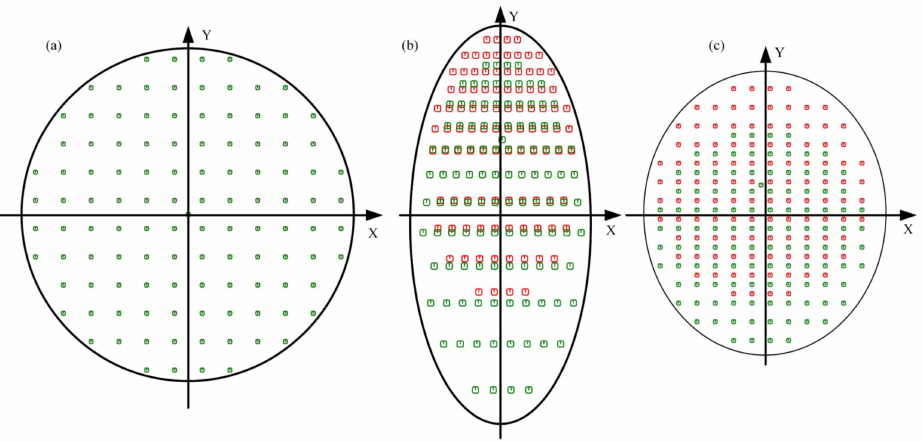
Figure 3. The red marks and the green marks, respectively, represent the intersections of sampled rays from two different fields, on the ( a ) pupil and ( b , c ) two different surfaces. The aperture limits are shown as black circles or